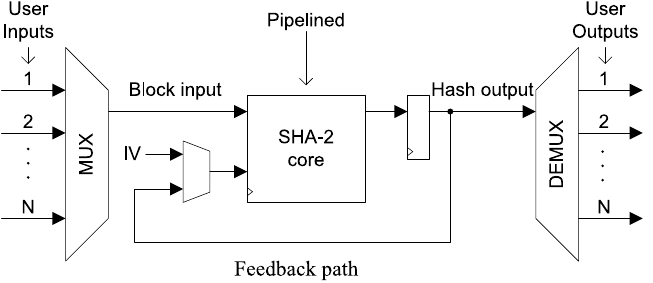
Figure 14. Block diagram of SHA-2 cryptographic hash application.